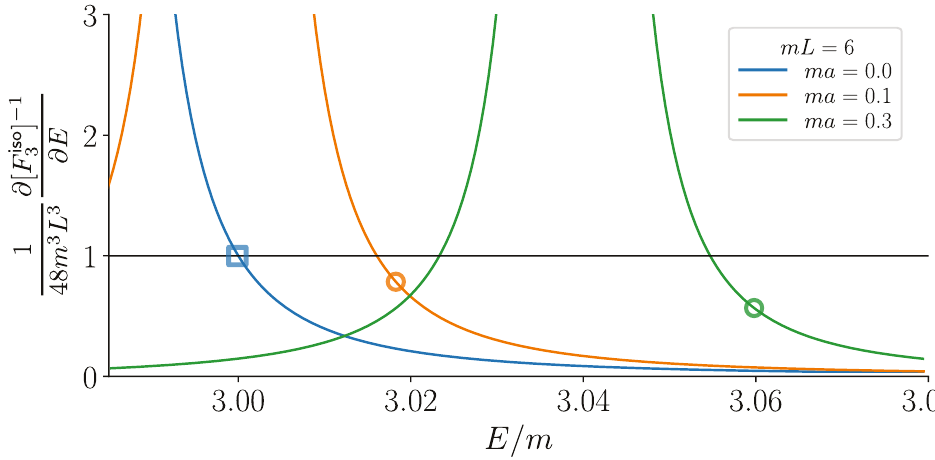
. The factor df , 3 , 3 = df , 3